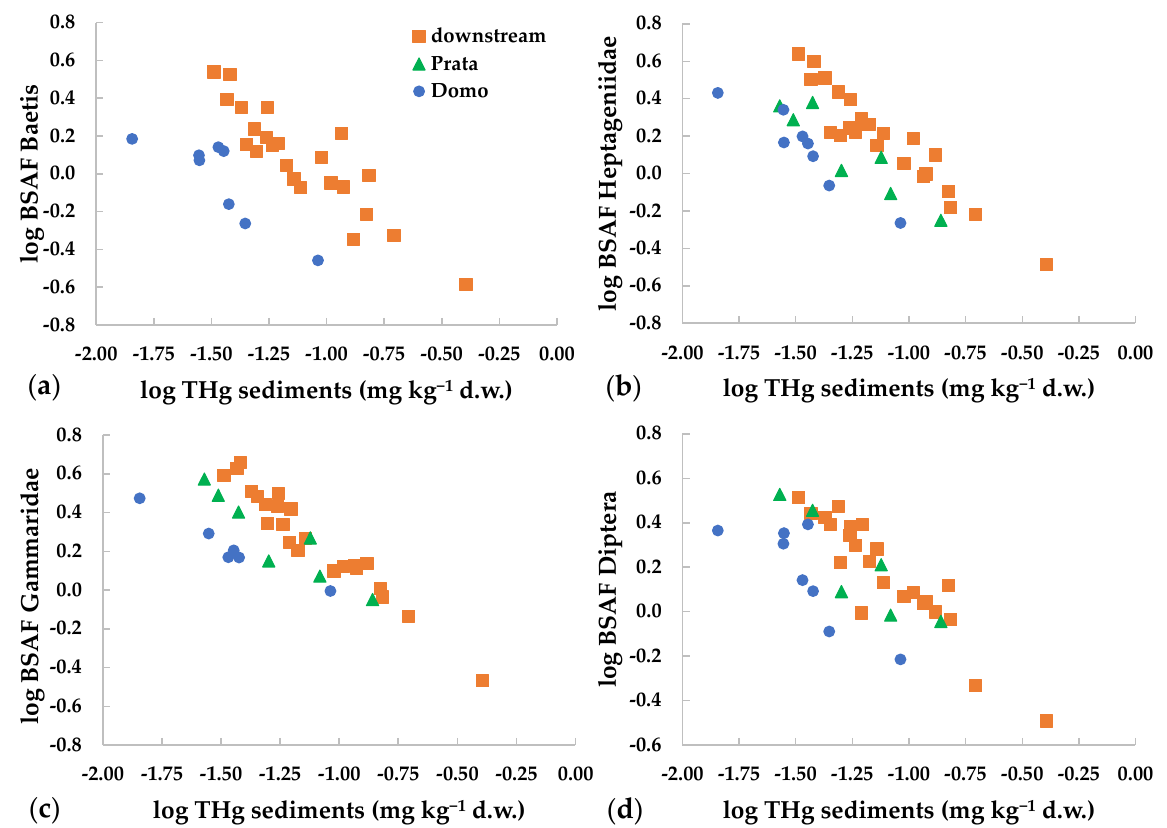
Figure 4. Relation between THg concentrations in sediments and BSAF values (log-transformed) for different invertebrate taxa collected at Domo, Prata and the three sites downstream of the industrial area (=downstream): ( a ) Baetis , ( b ) Heptageniidae, ( c ) Gammaridae, ( d ) Diptera.